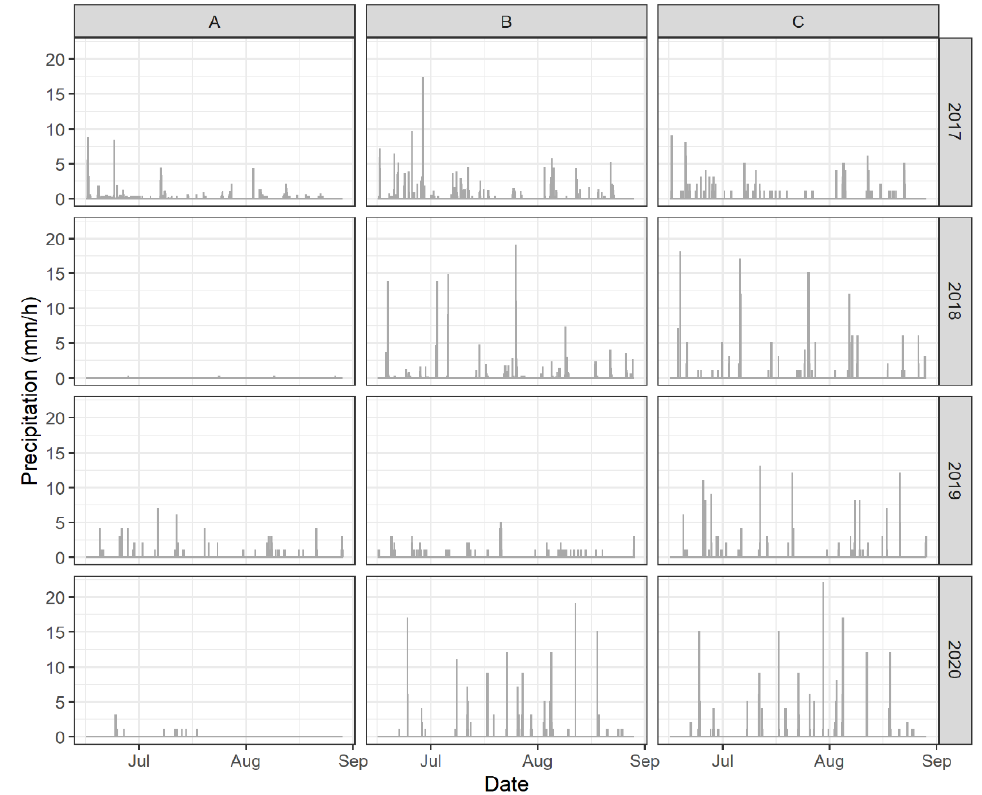
Figure 2. Hourly precipitation at each site ( A , B , C ) of each year (2017–2020) between 16 June, 0:00, and 28 August, 23:00.